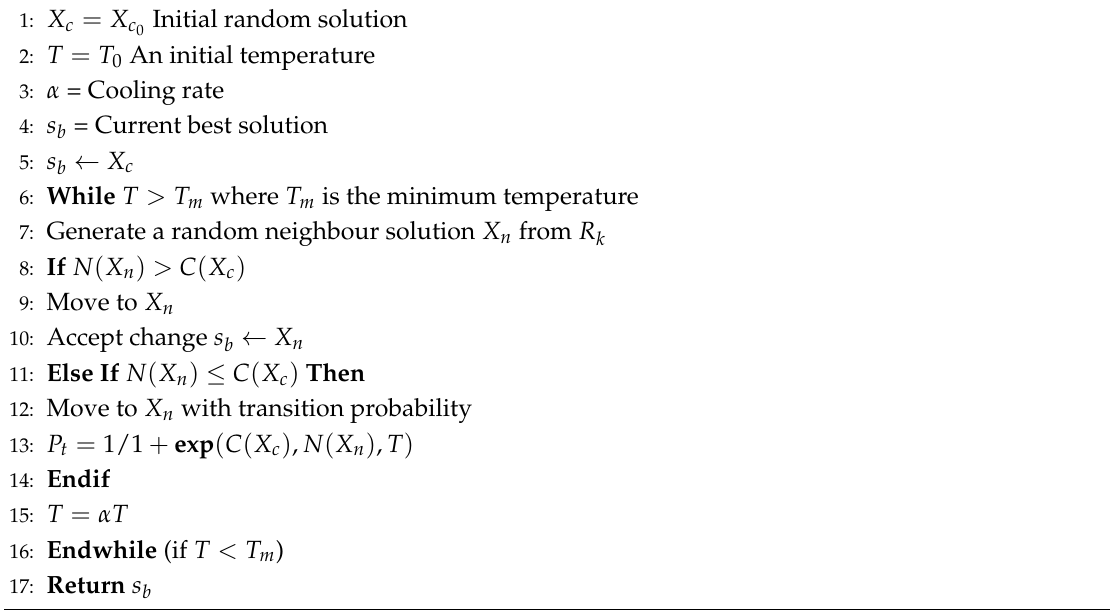
Algorithm 1 The simulated annealing algorithm for enhancing